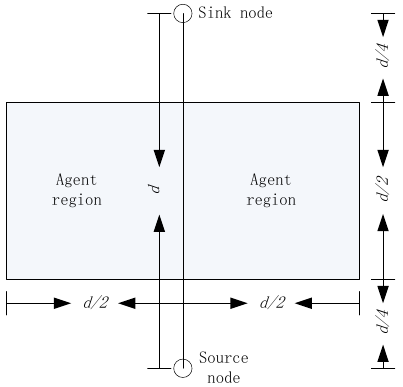
Figure 5. Agent region employed in this paper.